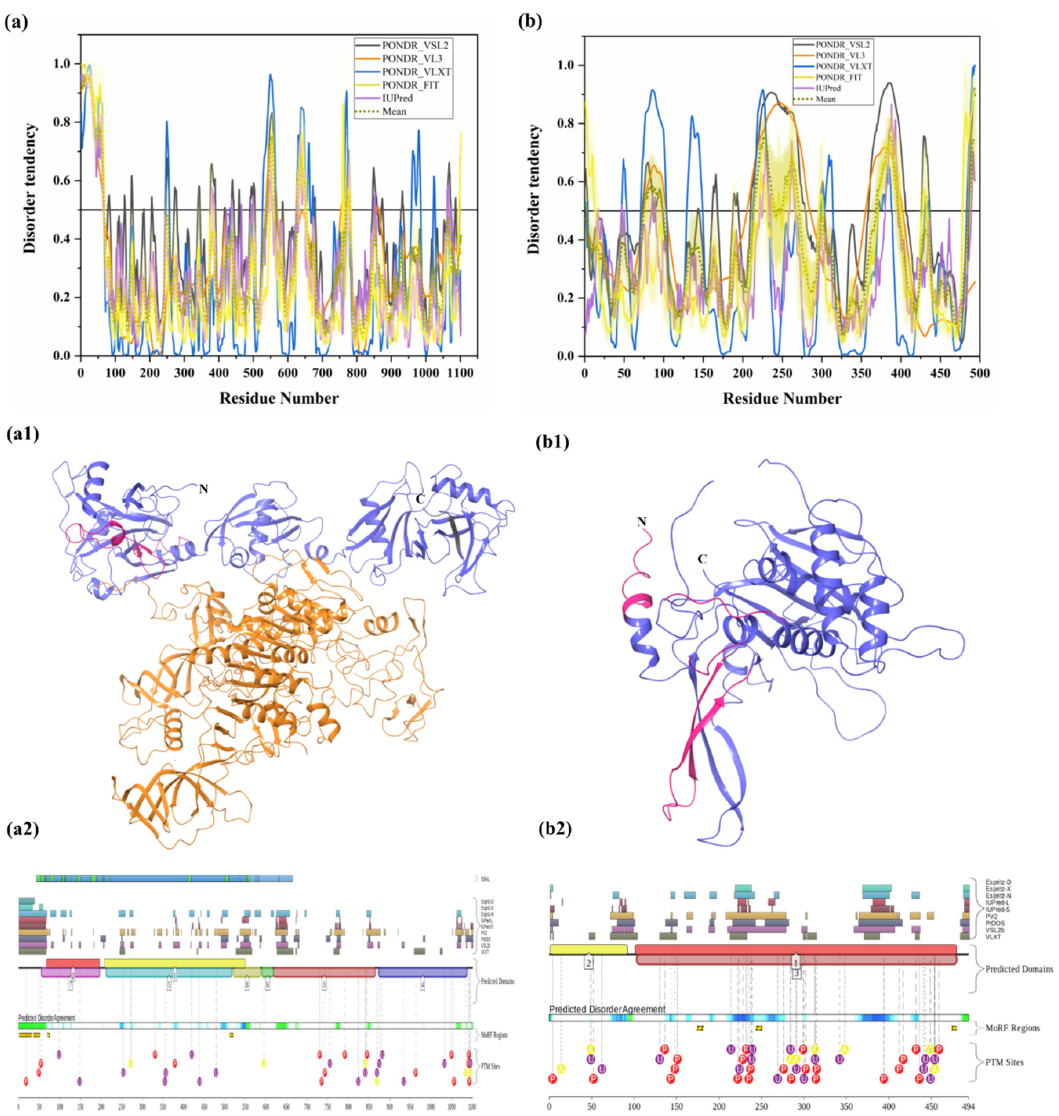
Figure 8. Intrinsic disorder predisposition and structural characterization of human USP7 and USP14. ( a ) Disorder profile of human USP7 (UniProt ID: Q93009). ( b ) Disorder profile of human USP14 (UniProt ID: P54578) ( a1 ) crystal structure of USP7 (PDB ID: 4YOC). ( b1 ) Crystal structure of USP14 (PDB ID: 4GJQ). In Plots ( a ) and ( b ), disorder profiles generated by sets of disorder predictors such as PONDR ® VSL2, PONDR ® VL3, PONDR ® VLXT, PONDR ® FIT, and IUPred are depicted by black, orange, blue, yellow, and purple curves respectively. The mean disorder profile calculated from the average of five predictor-specific per-residue disorder profiles is shown by the olive color curve. Predicted disorder scores above 0.5 are considered disordered residues / regions. The light-olive shadow around mean curve represents the error distribution for the mean. The light-yellow shadow around the PONDR ® FIT curve shows the error distribution for PONDR ® FIT. In Plots a1 and b1, USP7 and USP14 are represented by faded blue color; in Plot ( a1 ), human DNA (cytosine-5)-methyltransferase 1